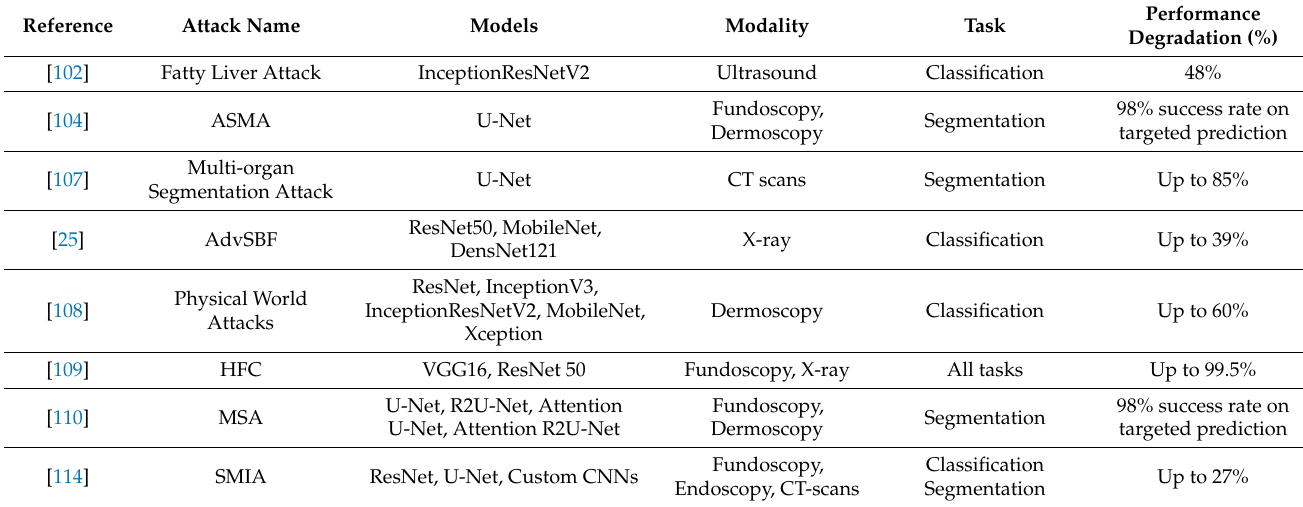
Table 2. Overview of medical adversarial